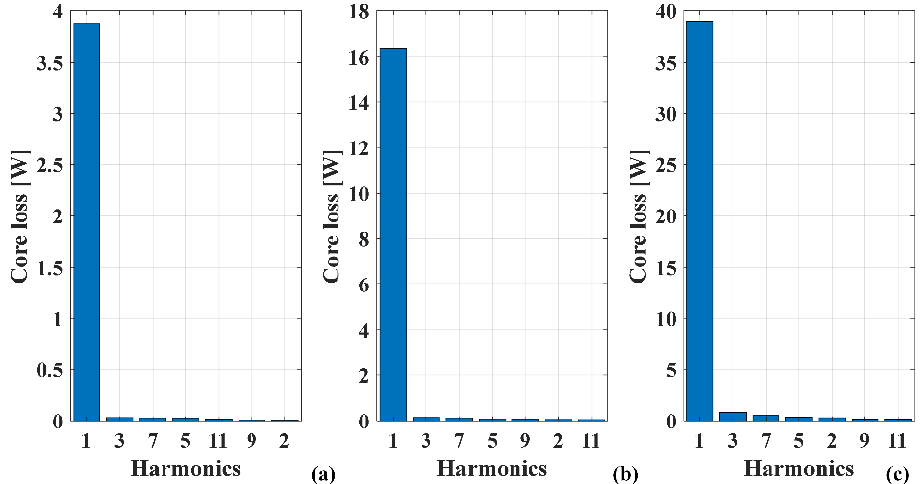
Figure 11. Analysis results of core loss according to magnetic flux density harmonics with sinusoidal current applied to the stator winding: ( a ) stator shoe, ( b ) stator tooth, and ( c ) stator yoke.